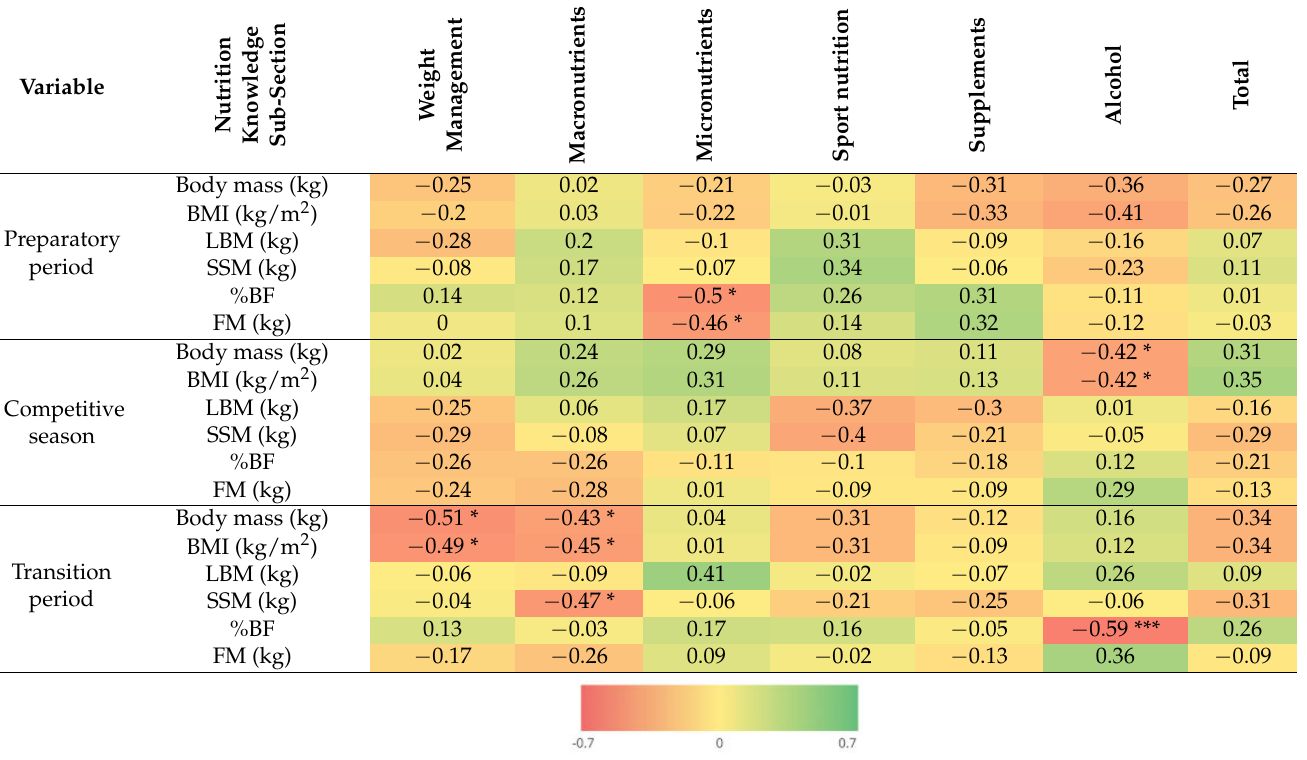
Table 3. Heat map showing Spearman’s R’ correlation coefficient values for the maximum and mini- mum body composition measures and level on the nutrition knowledge assessment for population aged 26 to 31. The results are visualized using a false color scale, where red indicates a negative correlation and green a positive